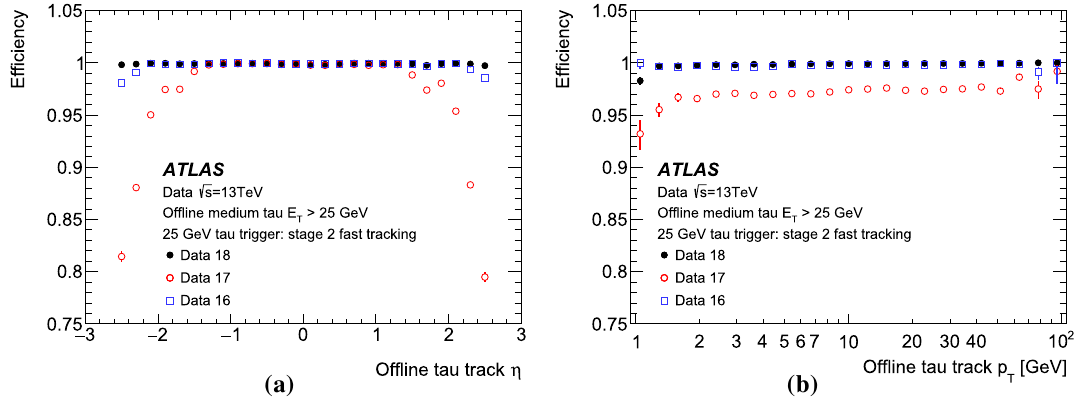
Fig. 34 The efficiency of the tau second stage fast tracking as a function of a pseudorapidity and b transverse momentum, comparing the performance in 2016, 2017, and